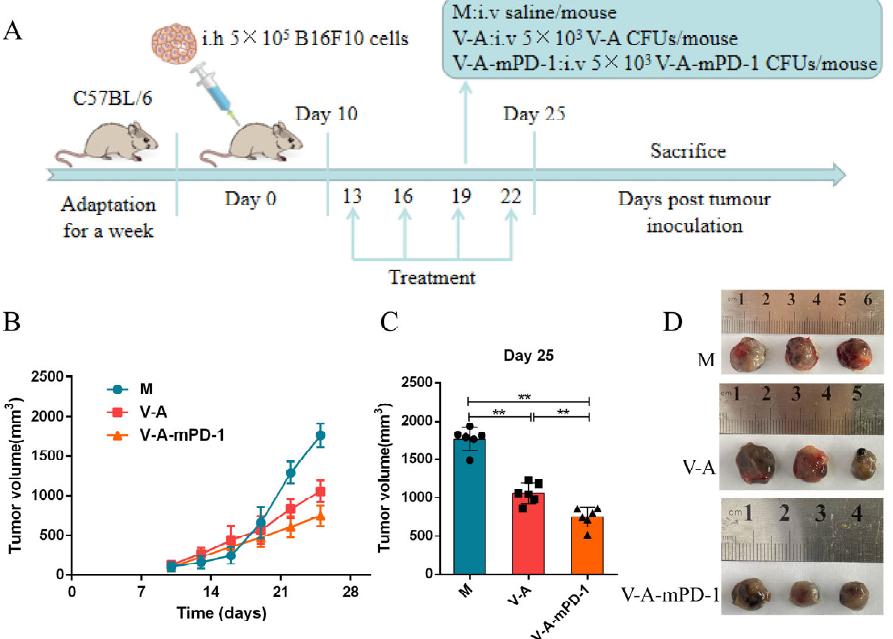
Figure 2. Inhibition of tumor growth in mice melanoma model by the anti ‐ tumor effect of the V ‐ A ‐ mPD ‐ 1 strain. ( A ) Treatment schedule for mice bearing B16F10 melanoma models. ( B ) Changes in tumor volume over time in M, V ‐ A, V ‐ A ‐ mPD ‐ 1 group. ( C ) Tumor size of mice in each group at day 25. ( D ) Images of tumor in M, V ‐ A, V ‐ A ‐ mPD ‐ 1 group at day 25. M group, the melanoma mice were